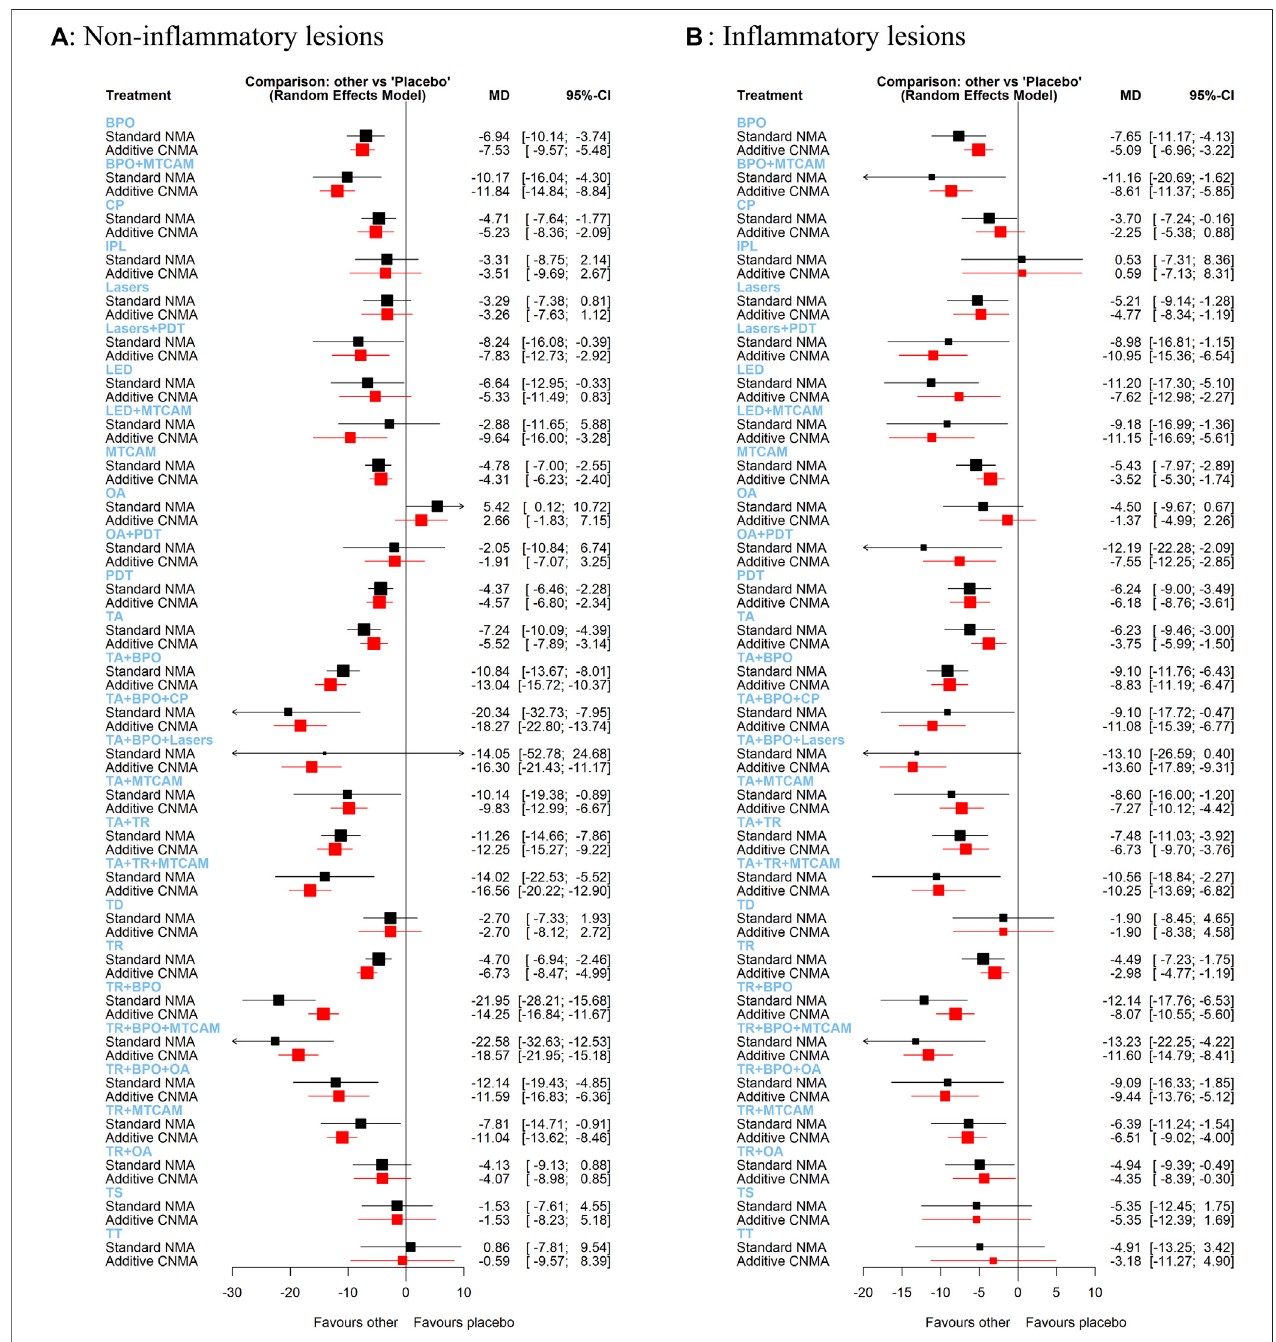
FIGURE 5 | Forest plots of frequentist additive network meta-analysis. (A) Mean difference of nonin fl ammatory lesions count. (B) Mean difference of in fl ammatory lesions count.